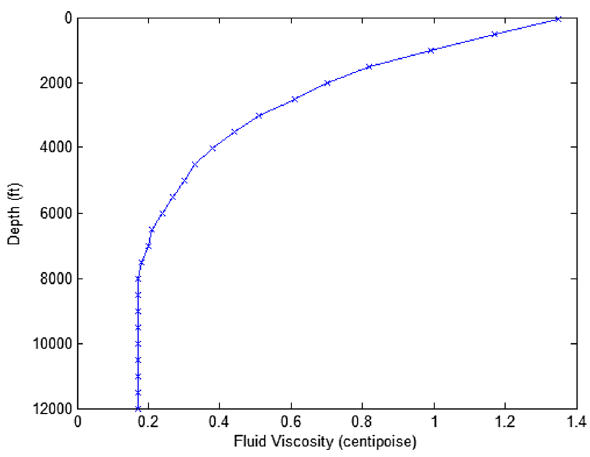
Fig. 10 Temperature profile in the well for choke size of 44/64 inches